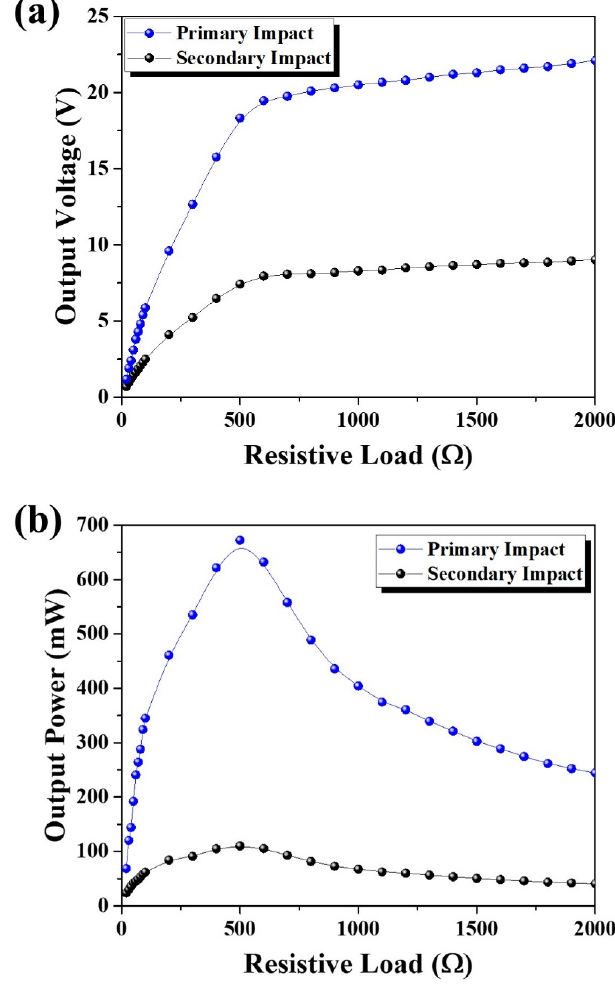
Figure 6. ( a ) Output-voltage and ( b ) output-power characteristics of hammer-impact-driven power generator, depending on alignment direction of buzzer-type piezoelectric energy converter, at 150 RPM, under various resistive loads, from 10 Ω to 2 k Ω .